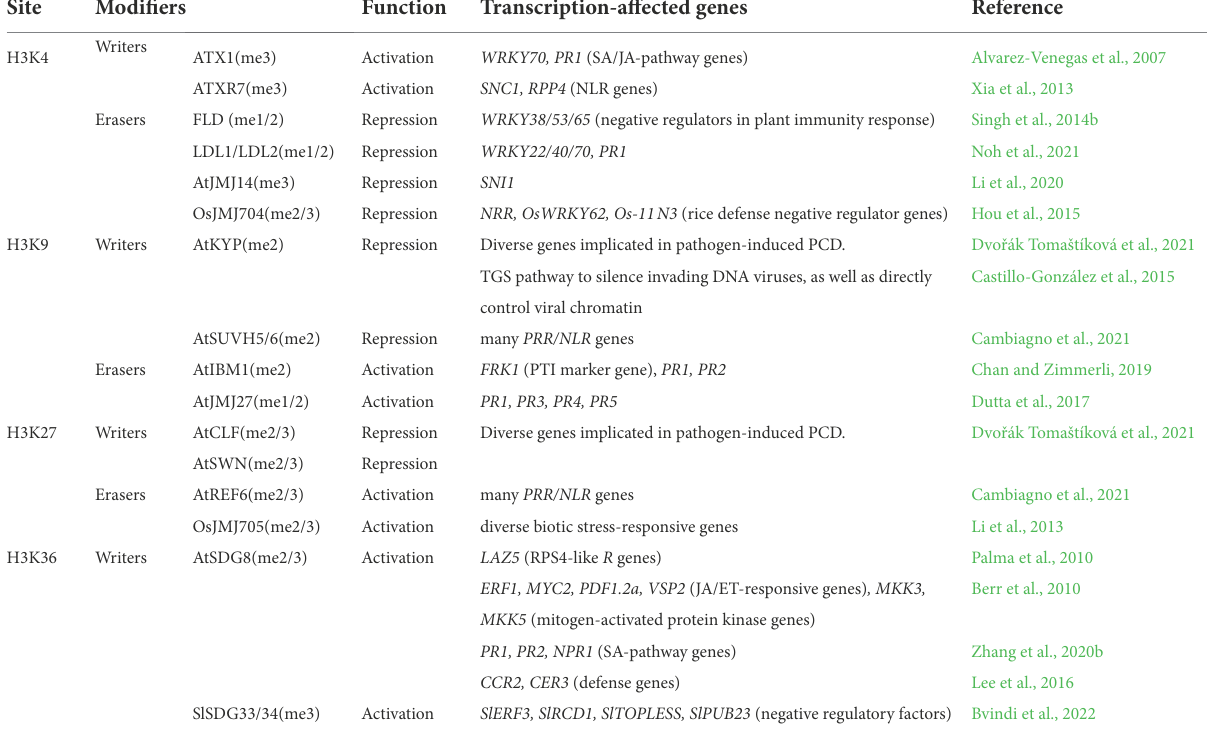
TABLE 1 Histone methyltransferases and demethylases implicated in plant response to pathogens.